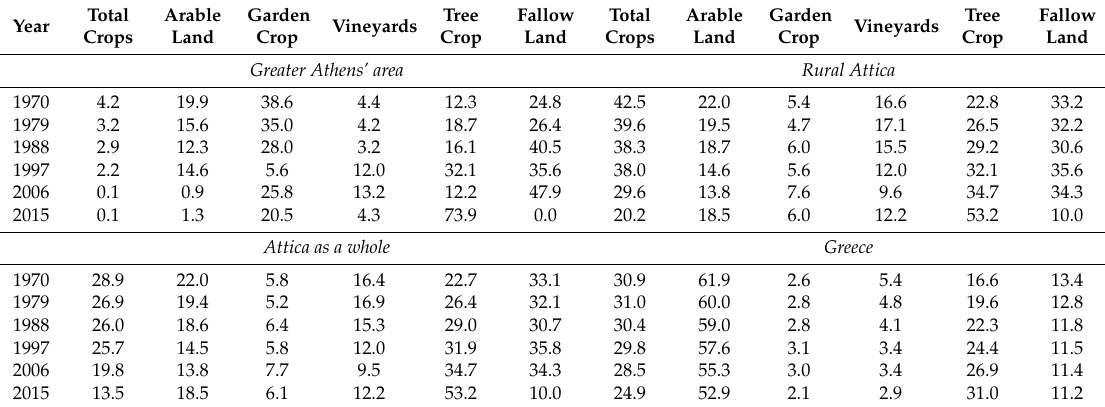
Table 1. Long-term trends in cropland and fallow land by land-use class in various geographic districts, Greece